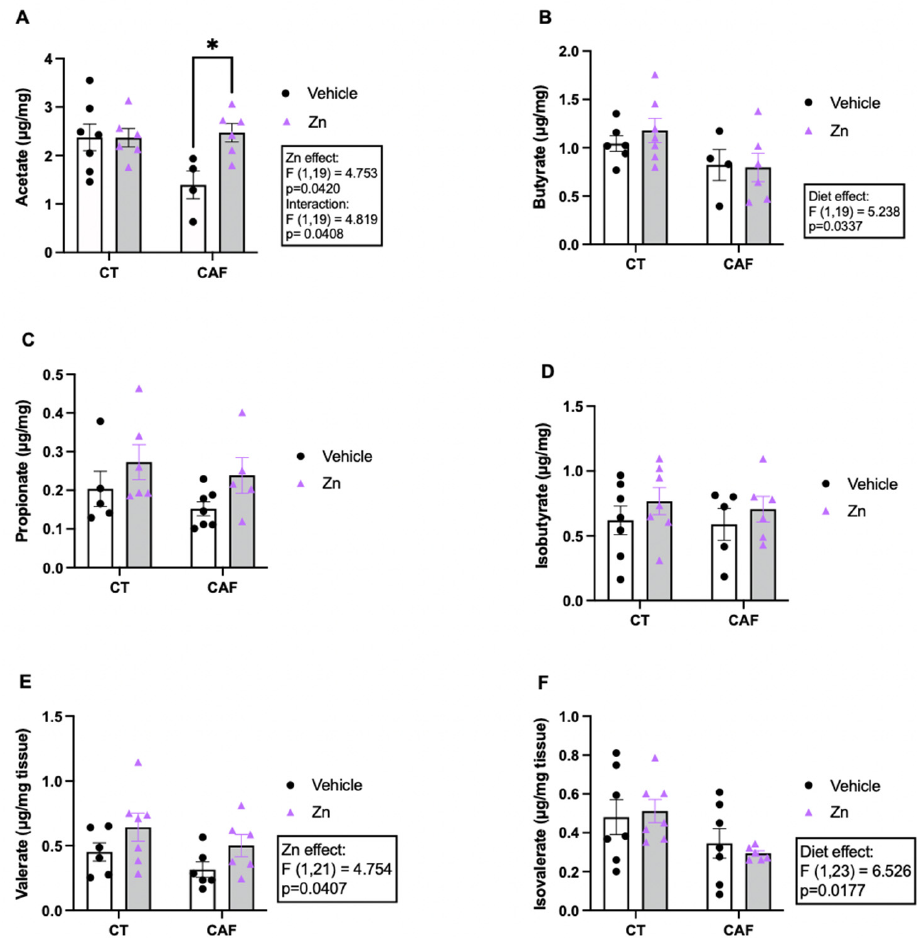
Figure 3. Short-chain fatty acid (SCFA) concentration in the proximal portion of the colon of control (CT) and cafeteria diet (CAF)-fed rats. ( A ) Acetate, ( B ) butyrate, ( C ) propionate, ( D ) isobutyrate, ( E ) valerate, and ( F ) isovalerate levels. The text box indicates significant differences shown by two-way ANOVA regarding the effects of diet (CT and CT + Zn vs. CAF and CAF + Zn), Zn supplementation (CT and CAF vs. CT + Zn and CAF + Zn), and the interaction between diet and Zn supplementation. Multiple comparisons were performed by Bonferroni post hoc test and significant differences are shown by the asterisk (* p < 0.05). n = 4–7 animals/group.